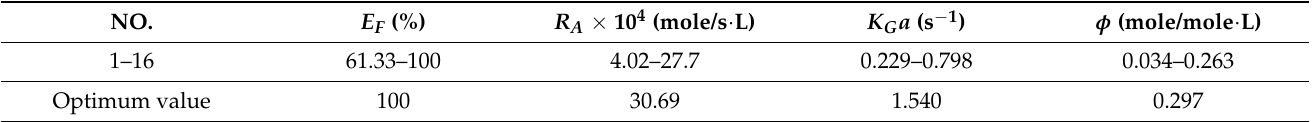
Table 7. Confirmation of the optimum condition.